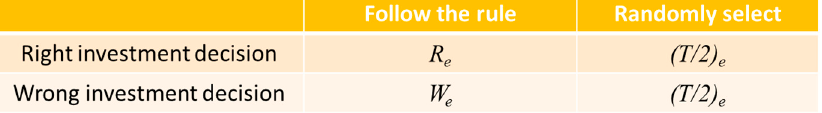
Figure 4. Expected frequencies: f e.